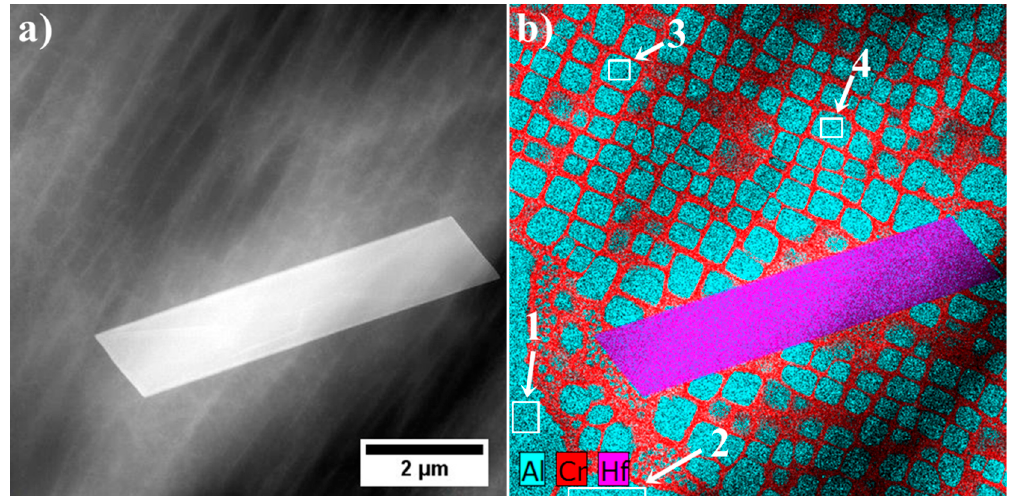
Figure 17. ( a ) location of mapping; ( b ) distribution of selected alloying elements in the area of primary Figure 17. a ) location of mapping; b ) distribution of selected alloying elements in the area of primary γ (cid:48) , secondary γ (cid:48) , and MC carbide, STEM-EDX. γ ', secondary γ ', and MC carbide, STEM-EDX. Table 6. Chemical composition of the primary and secondary γ ' precipitates in interdendritic space, STEM-EDX, at%.